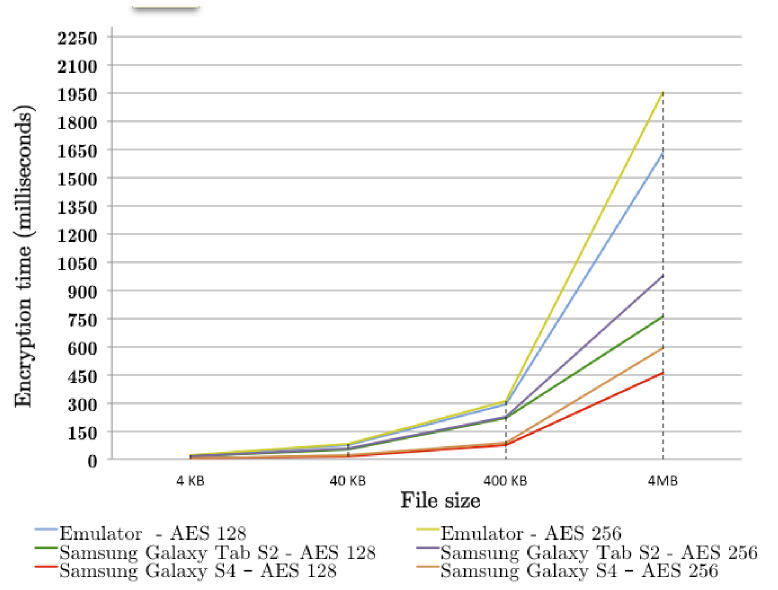
Figure 10. Average encryption time for several file sizes.